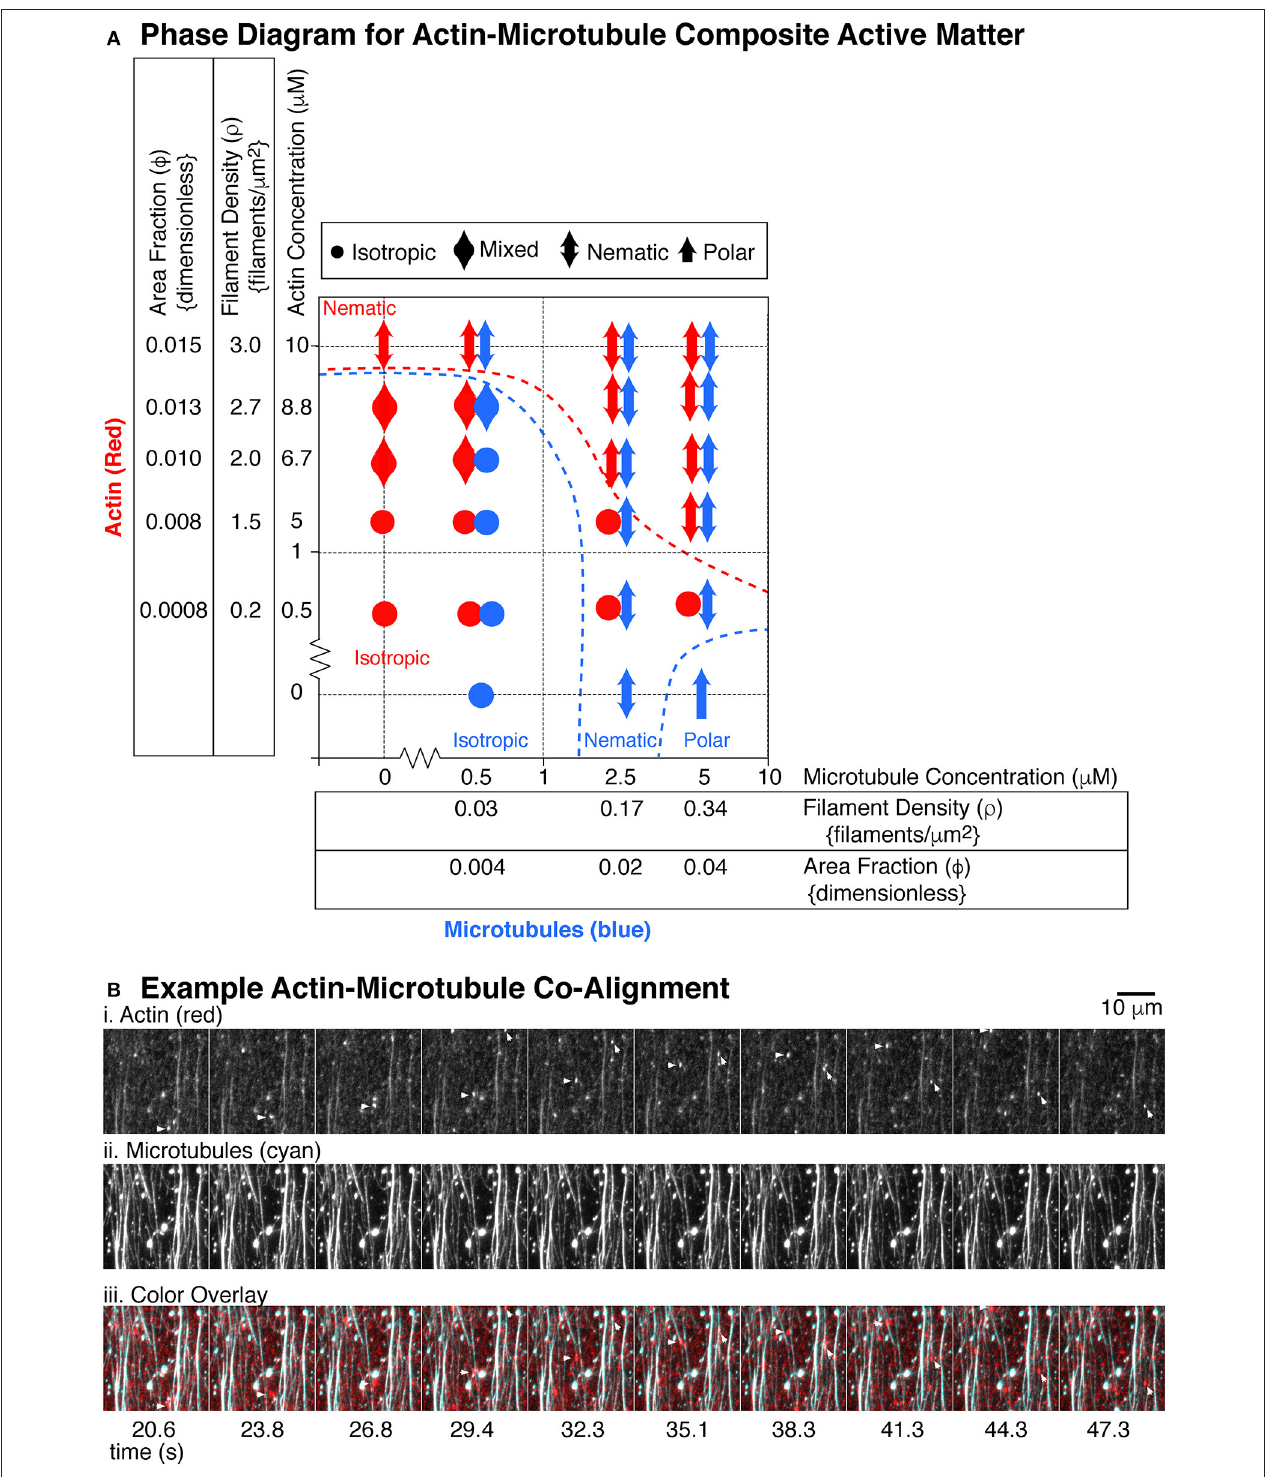
FIGURE 7 | State diagram for actin and microtubule composite gliding assays. (A) The actin filaments (red markers) were used at five different concentrations: 0.5, 5, 6.7, 8.8, and 10 µ M corresponding to the following filament densities (filaments per µ m 2 ): 0.2, 1.5, 2.0, 2.7, 3.0 and the following dimensionless area fractions: 0.0008, 0.008, 0.010, 0.013, 0.015. The microtubules (blue markers) where used at three different concentrations: 0.5, 2.5, and 5 µ M corresponding to the following